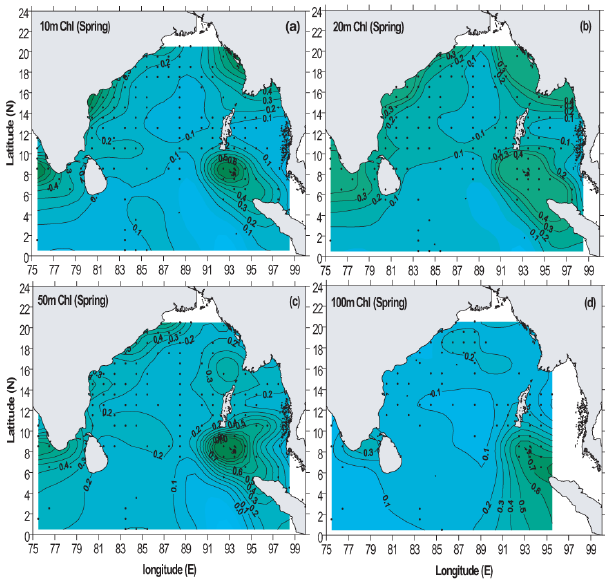
Figure 12. Spatial distribution of nitrate (µM) at (a) 10, (b) 20, (c) 50, and (d) 100m during summer monsoon. Note the change in contour interval in (c) and (d)